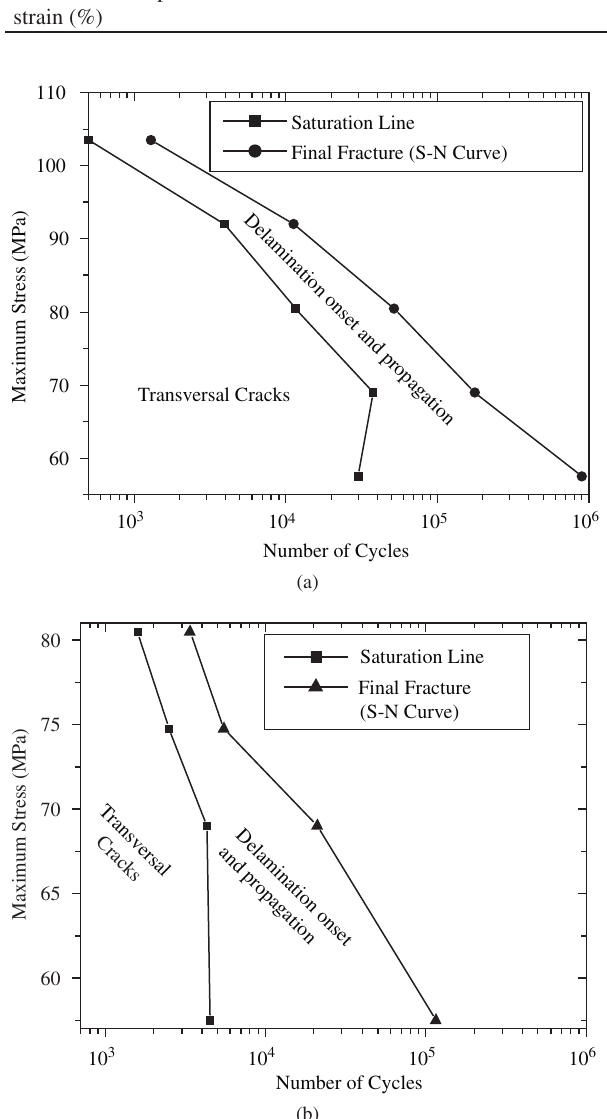
Figure 1. Damage Formation and Propagation Diagrams (DFPD) for lami- nates: a) C10; b) C12 with R =